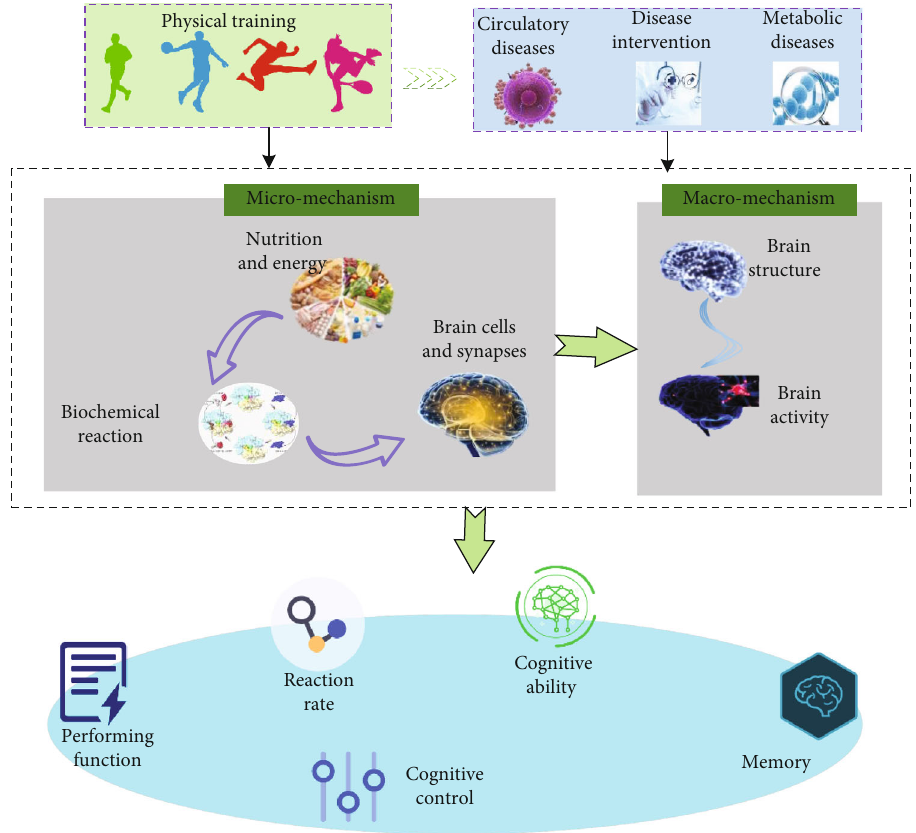
Figure 1: The role model of physical training in promoting cognitive function.